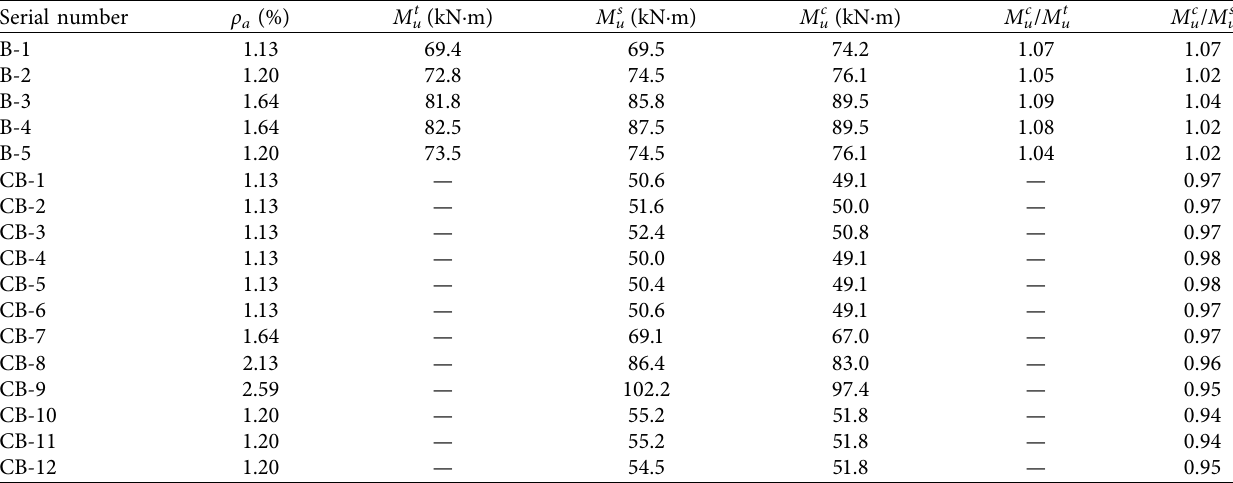
Table 3: Comparison of flexural capacities for tests, simulation, and formula.